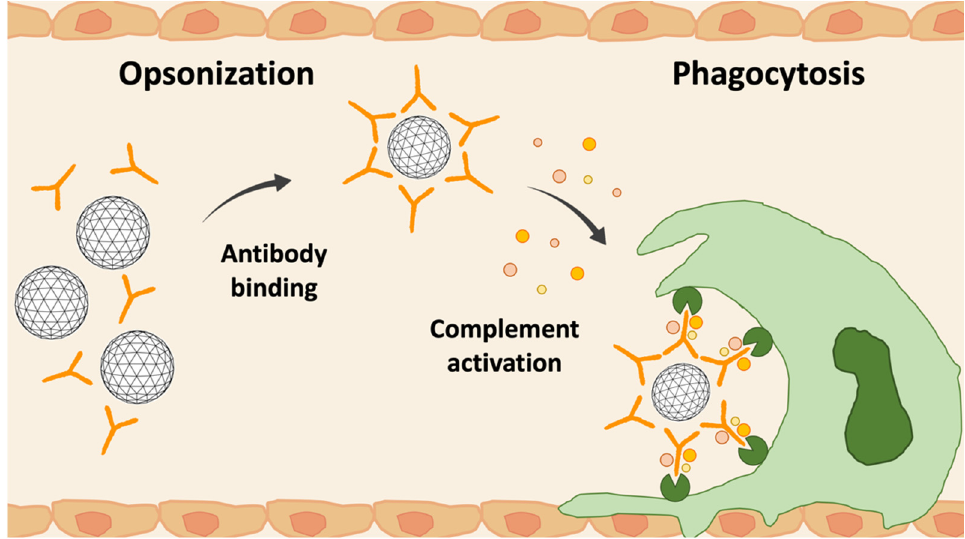
Figure 4. Opsonization process. Serum proteins are absorbed on the NPs’ surface leading to the opsonization process; In liver vessels (endothelial cells in orange), opsonized particles are subsequently recognized through receptors on phagocytic cells (green cell) and then internalized.